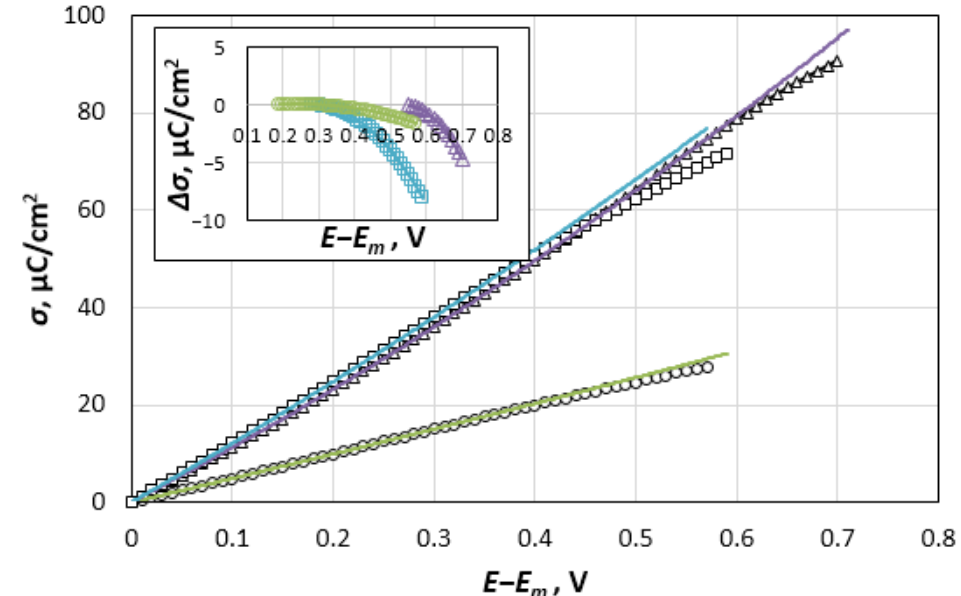
Figure 5. Charge density, σ , for the Re electrode as a function of the potential in NaCl ( ○ ), KCl ( ∆ ) and CsCl ( □ ) melts. Inset: The difference between the real and extrapolated charge density, ∆σ , at the region of potentials more positive than the E c .